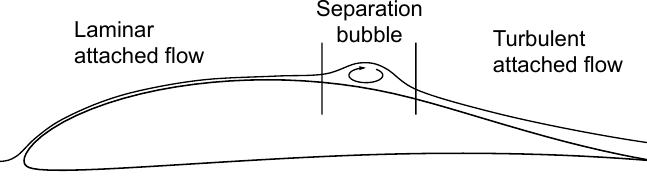
Figure 6. Laminar separation bubble